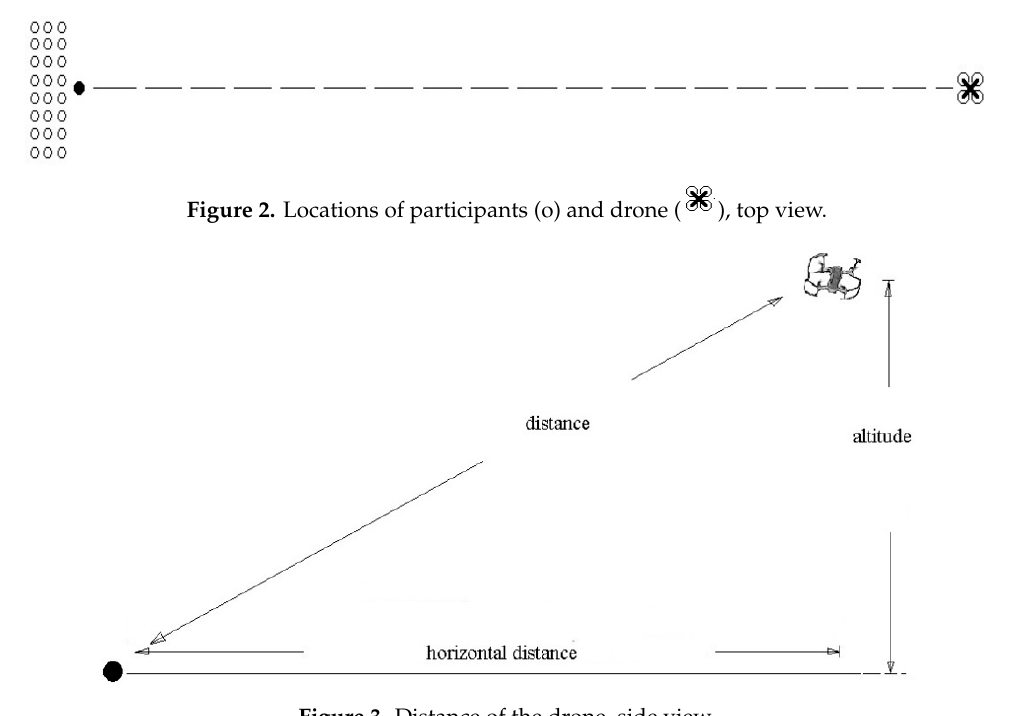
Figure 3. Distance of the drone, side view. Table 1. Drone hovering locations and visual angles.